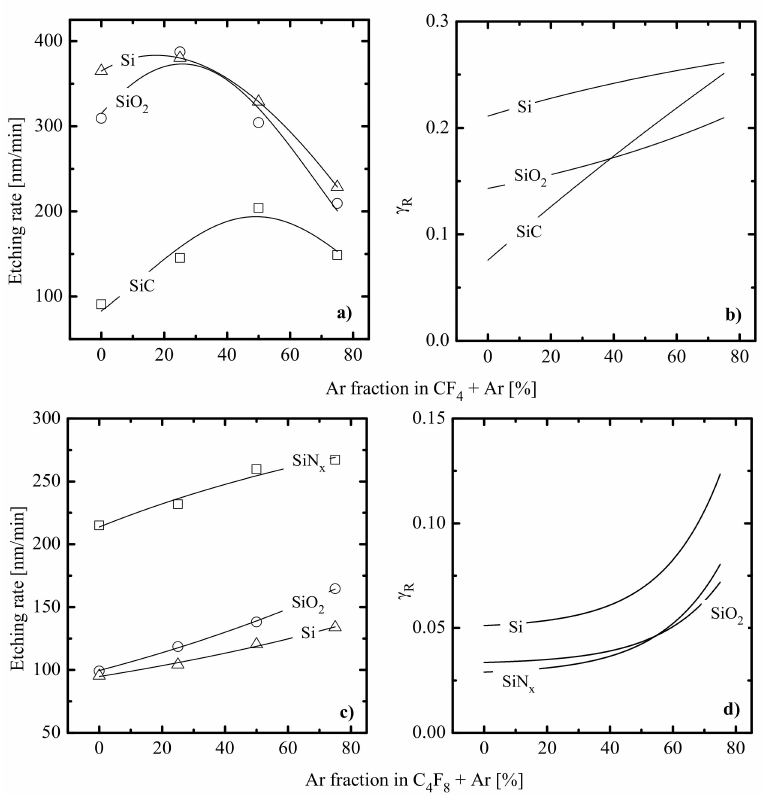
Figure 4. Etching rates ( a , c ) and effective reaction probabilities for F atoms ( b , d ) for various Si-based materials in CF 4 + Ar and C 4 F 8 + Ar plasmas. In ( a , b ): CF 4 + Ar plasma at p = 6 mTorr, W = 700 W and W dc = 300 W (for SiC and SiO 2 ) or p = 10 mTorr, W = 800 W and W dc = 300 W (for Si). In ( b , c